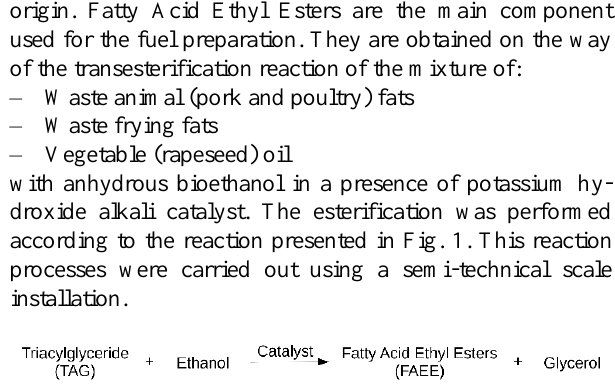
Fig. 1. Reaction of transesterification with ethyl alcohol